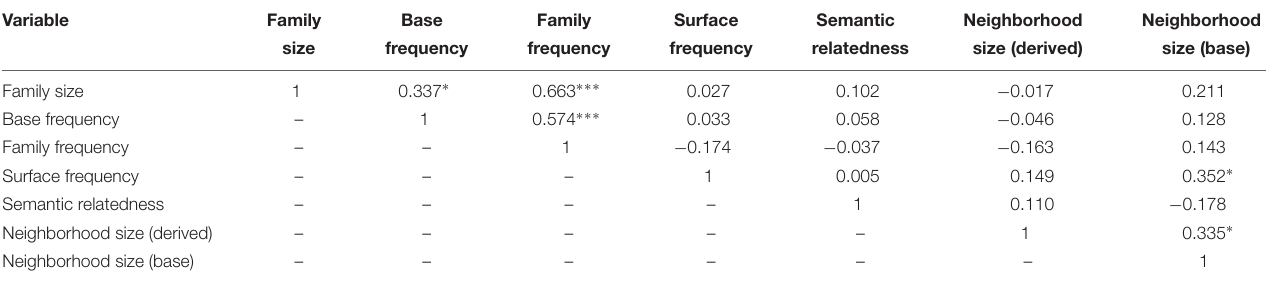
TABLE 1 | Correlations between measures of family size, base frequency, family frequency, surface frequency, semantic relatedness, neighborhood size of the derived word, and neighborhood size of the base word.